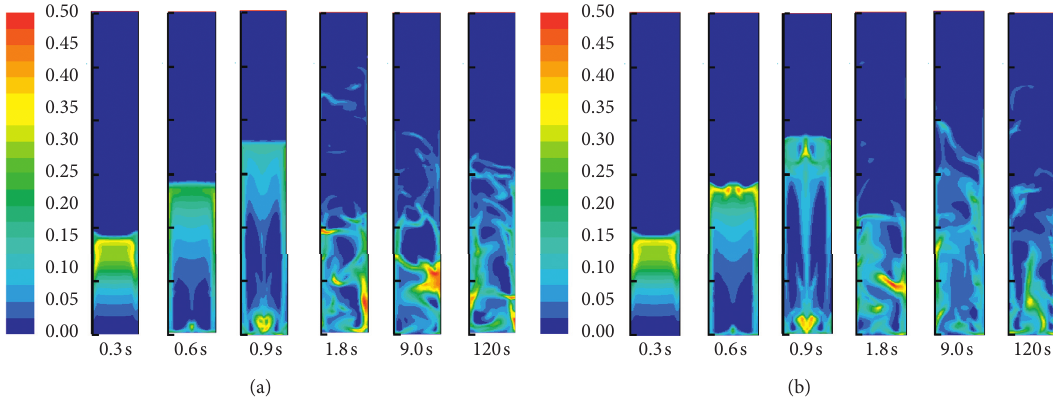
Figure 11: Volume fraction of tar mist: d � 0.30mm and ρ � 900kg/m 3 . (a) u � 0.70m/s. (b) u � 0.72m/s.